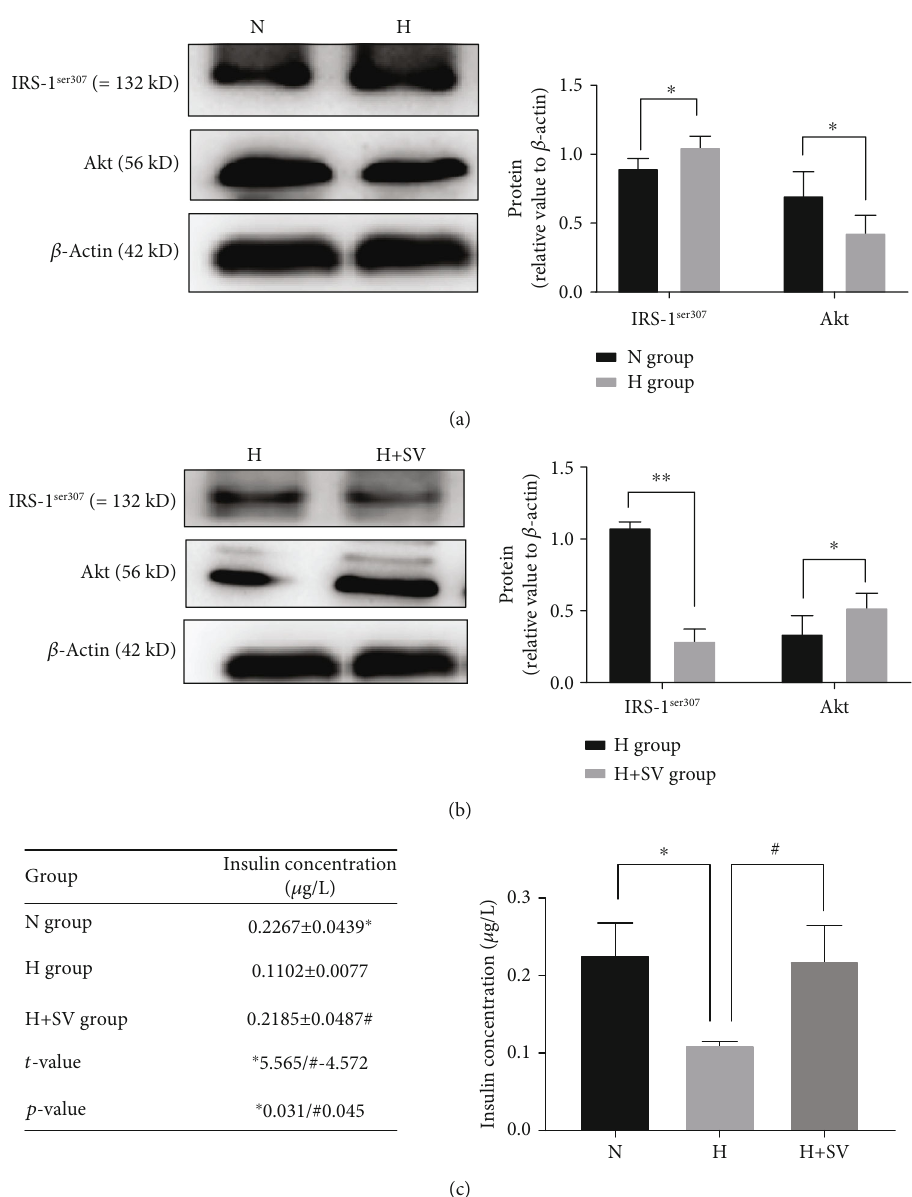
Figure 2: Expression of p-IRS-1 ser307 , Akt, and insulin in β -cells treated with di ff erent concentrations of T3. N group: normal-concentration T3 (5 pg/mL); H group: high-concentration T3 (20 pg/mL); H+SV group: high-concentration T3 (20 pg/mL)+sodium orthovanadate (5 μ mol/L). (a) Western blotting analysis showed that the expression of p-IRS-1 ser307 in the H group was signi fi cantly higher than that in the N group, whereas Akt was lower. (b) p-IRS-1 ser307 in the H+SV group was signi fi cantly lower than that in the H group, whereas Akt was higher than that in the H group. (c) ELISA showed that the concentration of insulin in the supernatant of the N group was signi fi cantly higher than that of the H group, whereas that of the H group was signi fi cantly lower than that of the H+SV group ( n = 5 , group = 3 , ∗ p < 0 : 05 , ∗∗ p < 0 : 01 ). ELISA: enzyme-linked immunosorbent